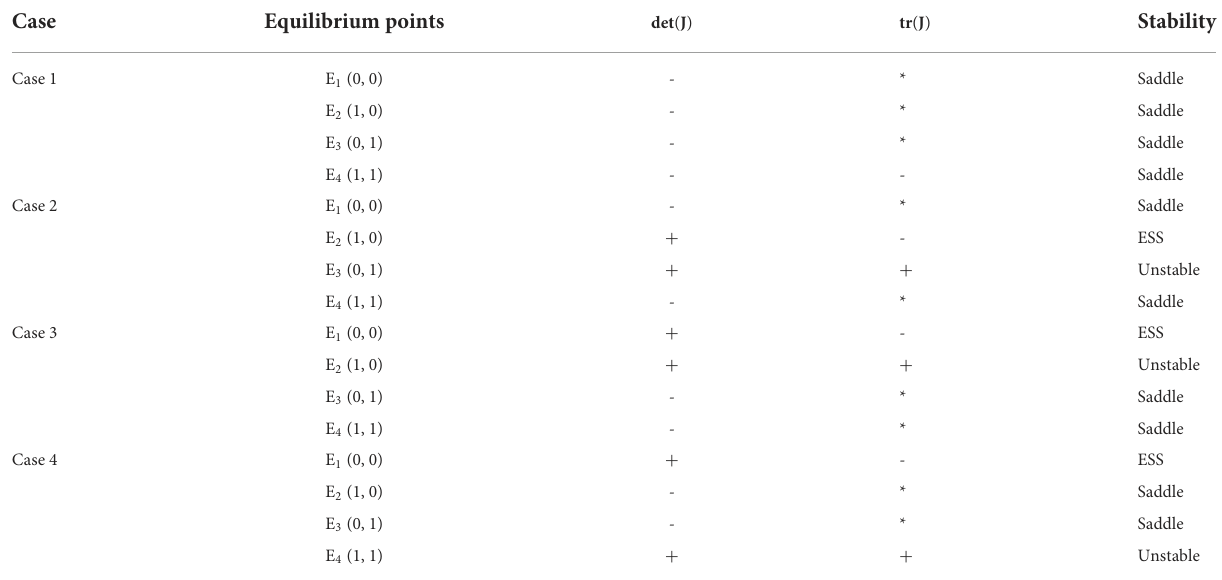
TABLE 4 Stability analyses of equilibrium points in case 1–4.